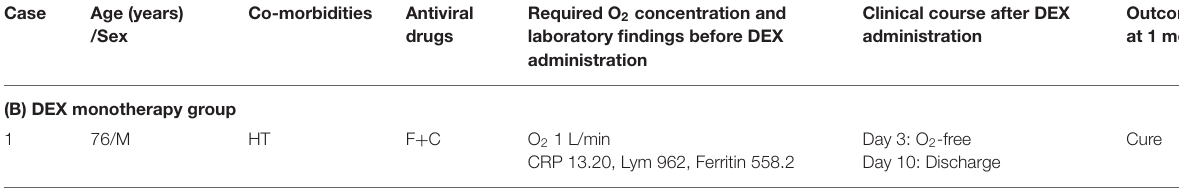
Required O 2 concentration and Clinical course after TCZ drugs laboratory findings before TCZ injection